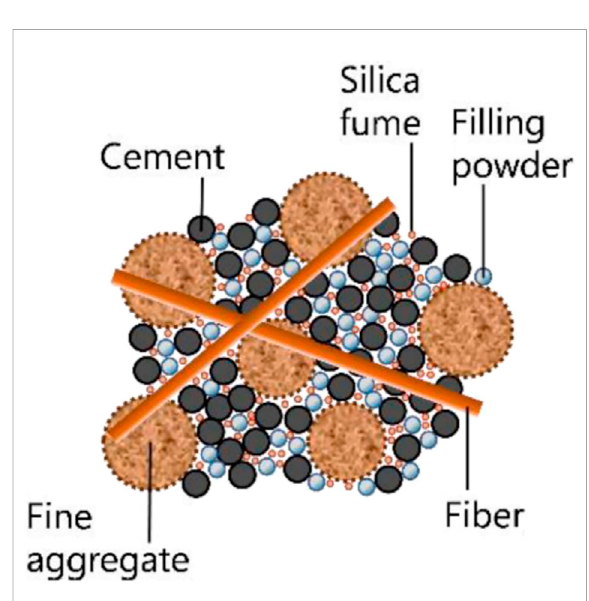
FIGURE 7 Schematic composition (not to scale) of fi ber-reinforced UHPC (taken from Park et al.